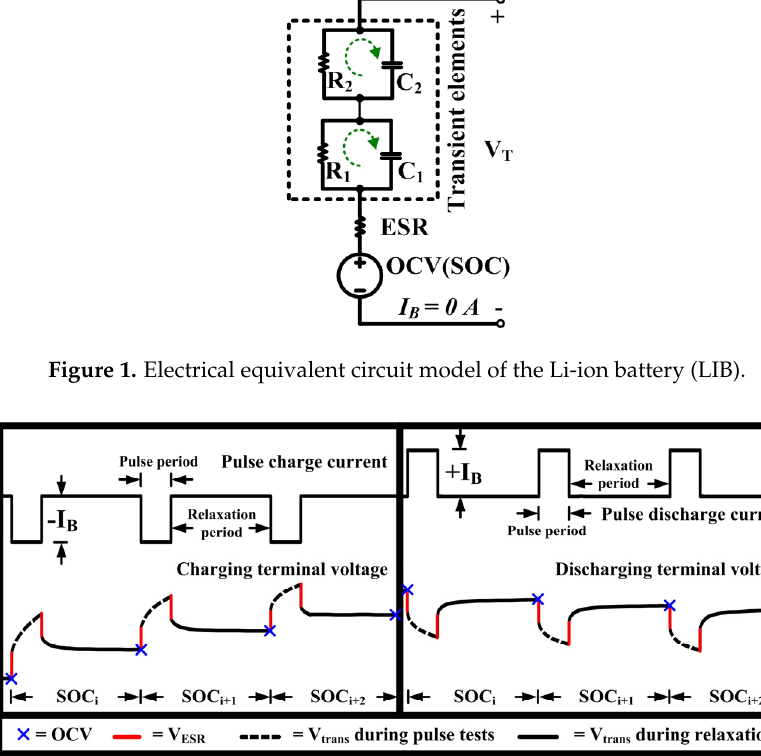
Figure 2. Current and voltage response for pulse tests to extract the open circuit voltage ( OCV ).